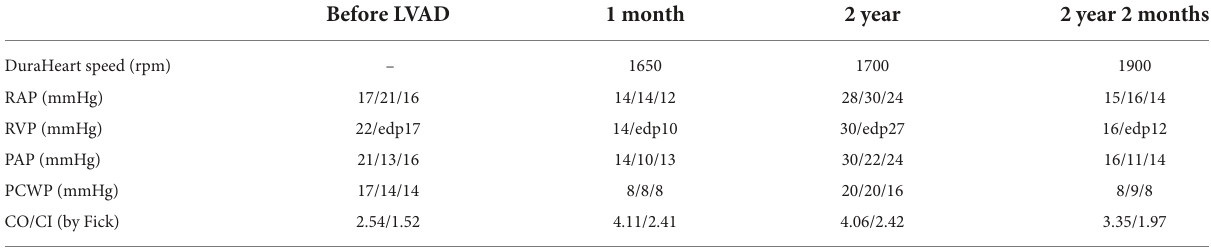
TABLE 4 Trend of right heart catheter study in Case 1.